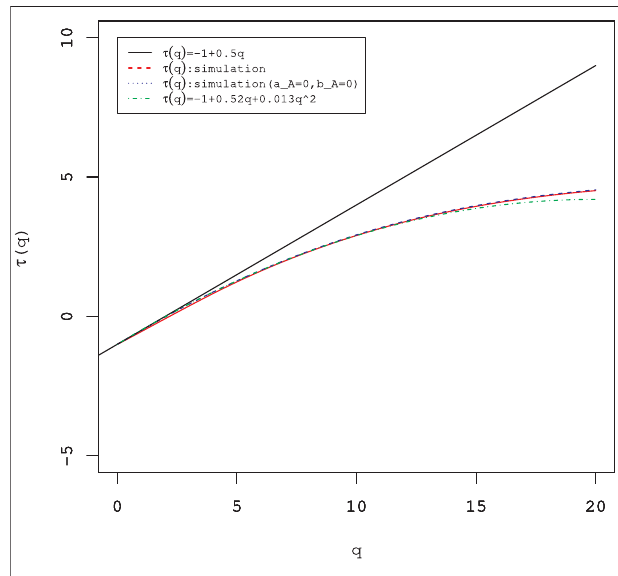
FIGURE 10 | Pdf of measured x ( λ ) and numerical calculation of the Fokker – Planck equation. The result of numerical calculation is represented by the solid lines. Marks are measured values. The scale is attached to each